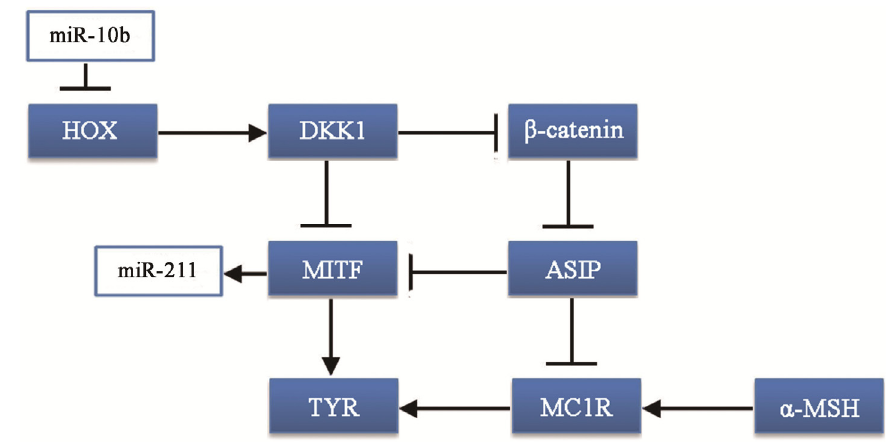
Figure 4. The possible regulatory pathway of melanogesis